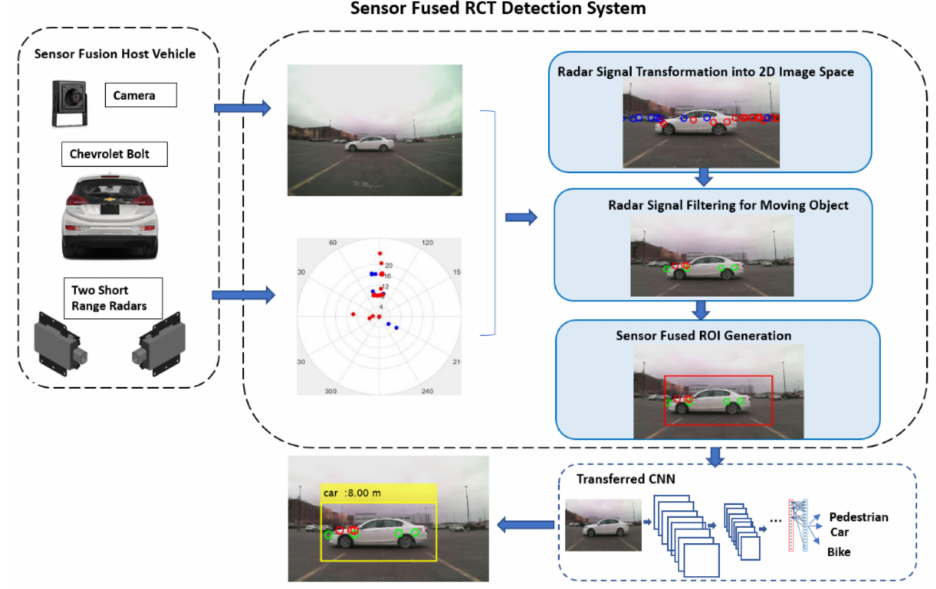
Figure 1. The overall architecture of the proposed RCT detection